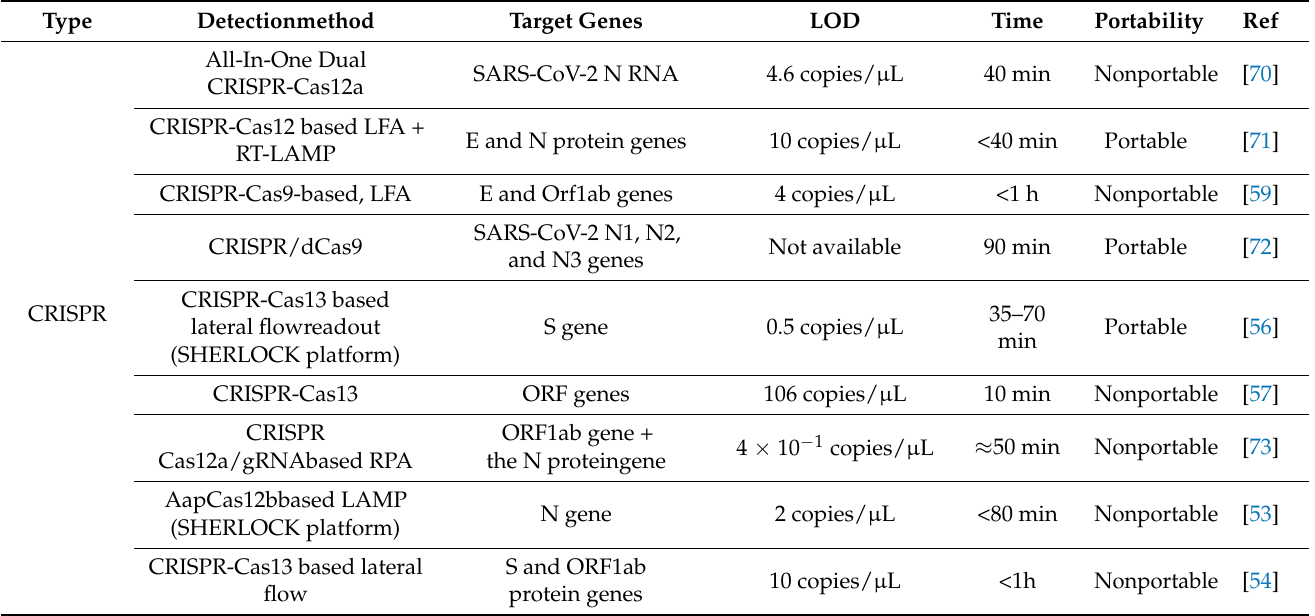
Table 3. Nucleic acid-based-biosensors for SARS-CoV-2